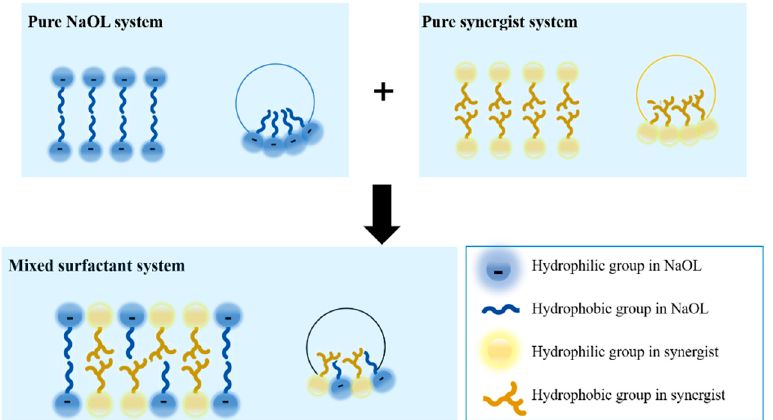
Figure 7. Schematic of the dilution effect in the mixed surfactant system showing the change in electrostatic self-repulsion and steric repulsion before and after mixing between NaOL and alcohol